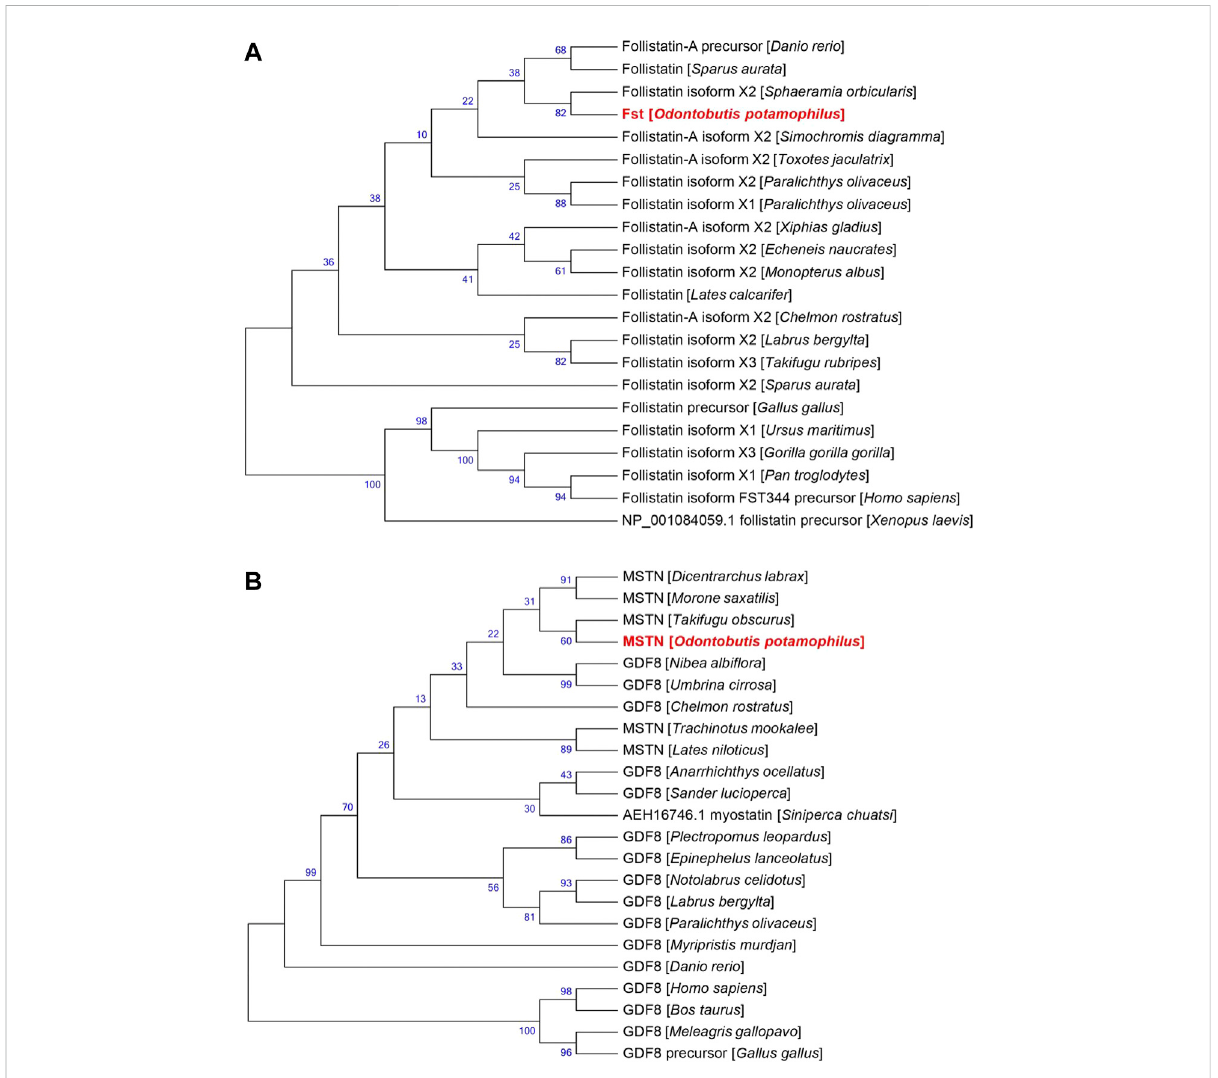
FIGURE 4 Evolutionary relationships of (A) FST and (B) MSTN in different